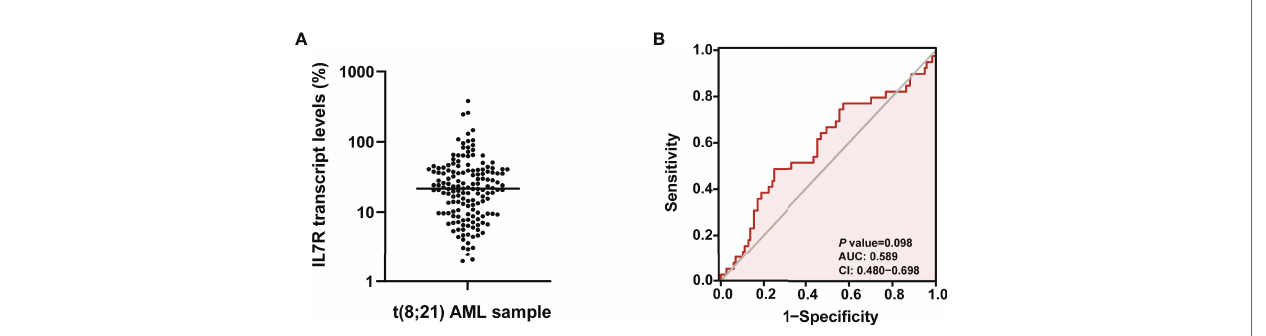
FIGURE 1 | (A) The expression pattern of IL7R transcript level in bone marrow of t(8;21) AML patients at diagnosis; (B) ROC curve analysis based on relapse were performed to determine the optimal cutoff value of IL7R transcript level for